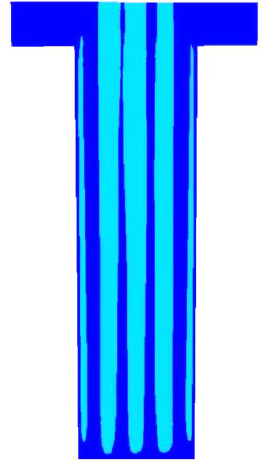
Figure 6. Fluid flow contour in sub-channel with cylindrical square array for forced convection.